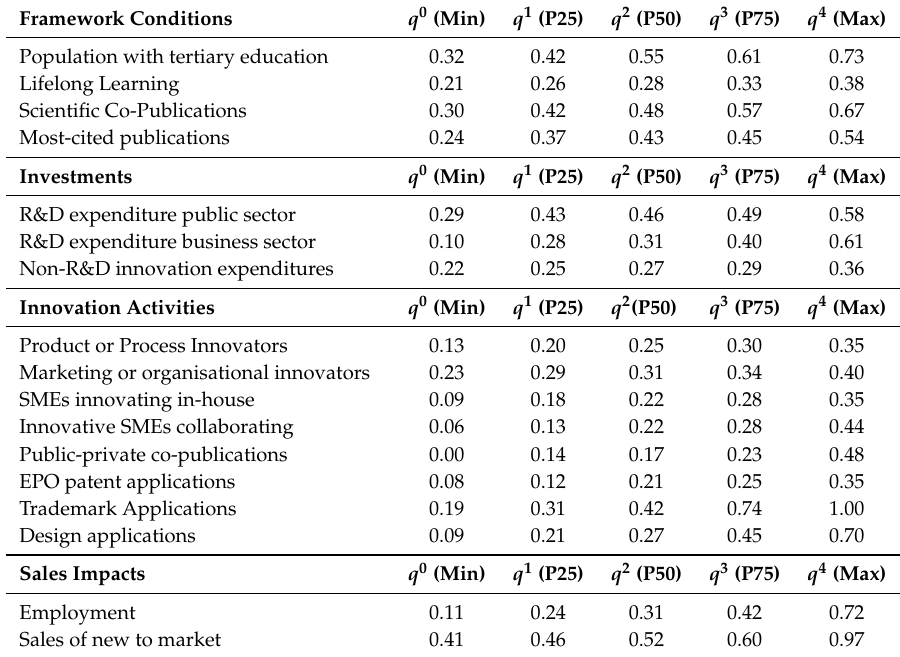
Table 3. Spain Regions’ Reference Levels of the RII indicator in 2019 relative to the Spanish Regions’.